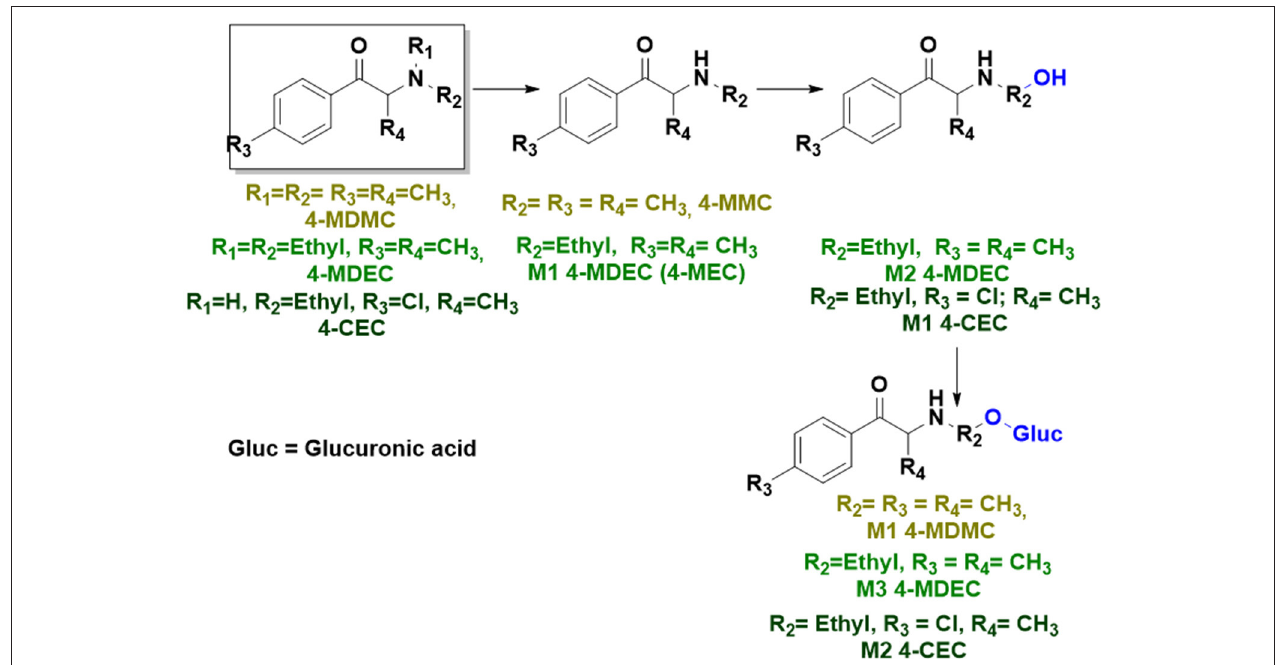
FIGURE 3 | Proposed structures for the metabolites identified by LC-HRMS/MS in RLM and HLM incubations of 4-MDMC , 4-MDEC, and 4-CEC